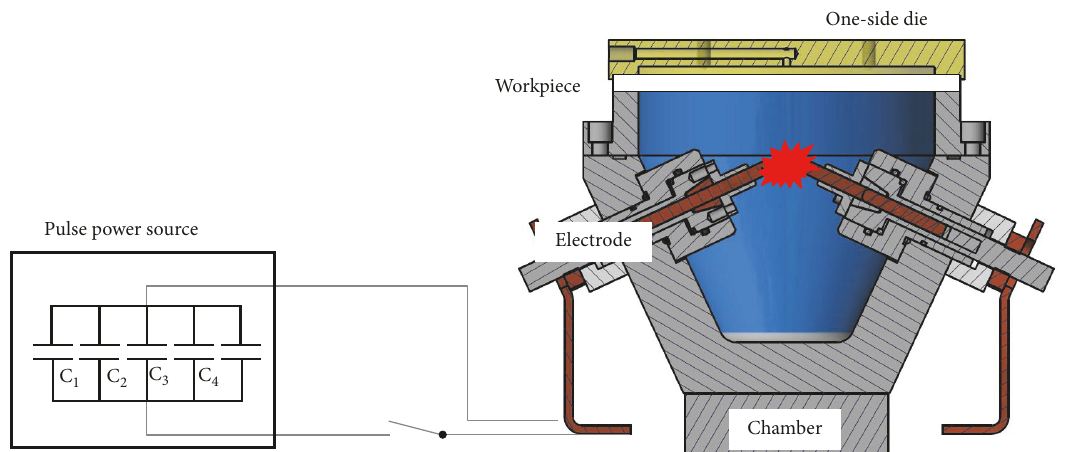
Figure 1: Cross-sectional diagram of an EHF